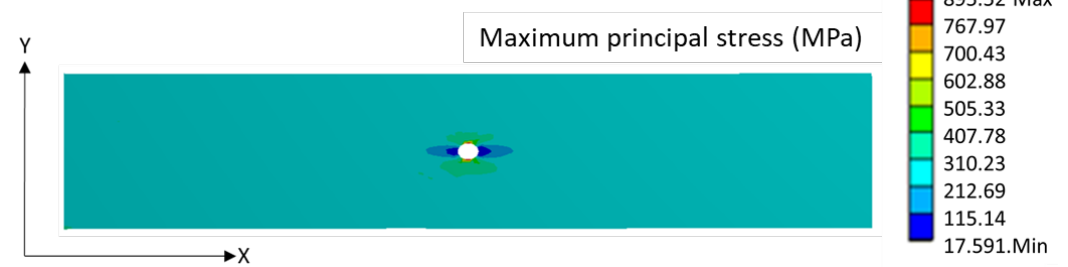
Figure 8. Maximum principal stress distribution for 4 mm notched f [0°] 4 laminate.